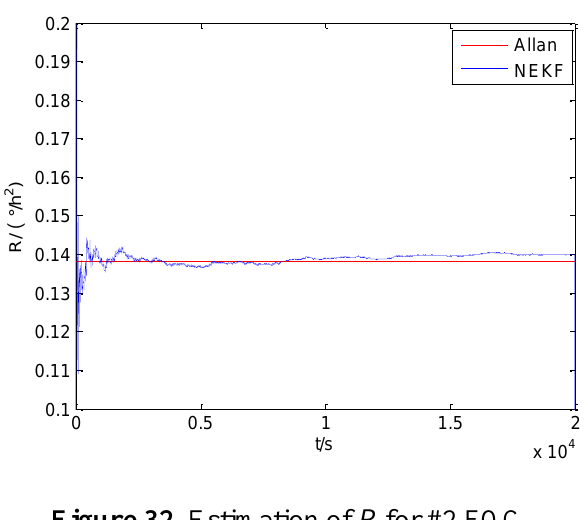
Figure 32. Estimation of R for #2 FOG. Table 3. Results of estimated parameters by the Allan variance and proposed